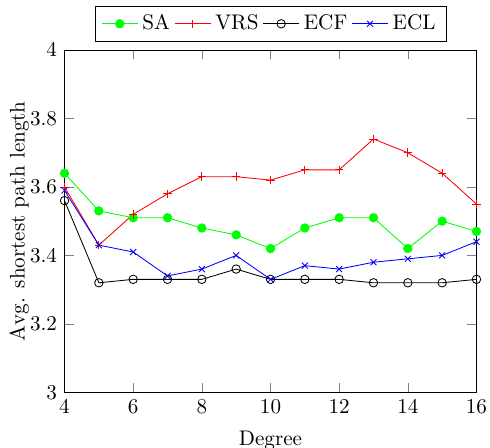
Figure 4. Average hop count for different degree limit values per switch. The proposed ECL and ECF consistently achieve lower average hop count across various